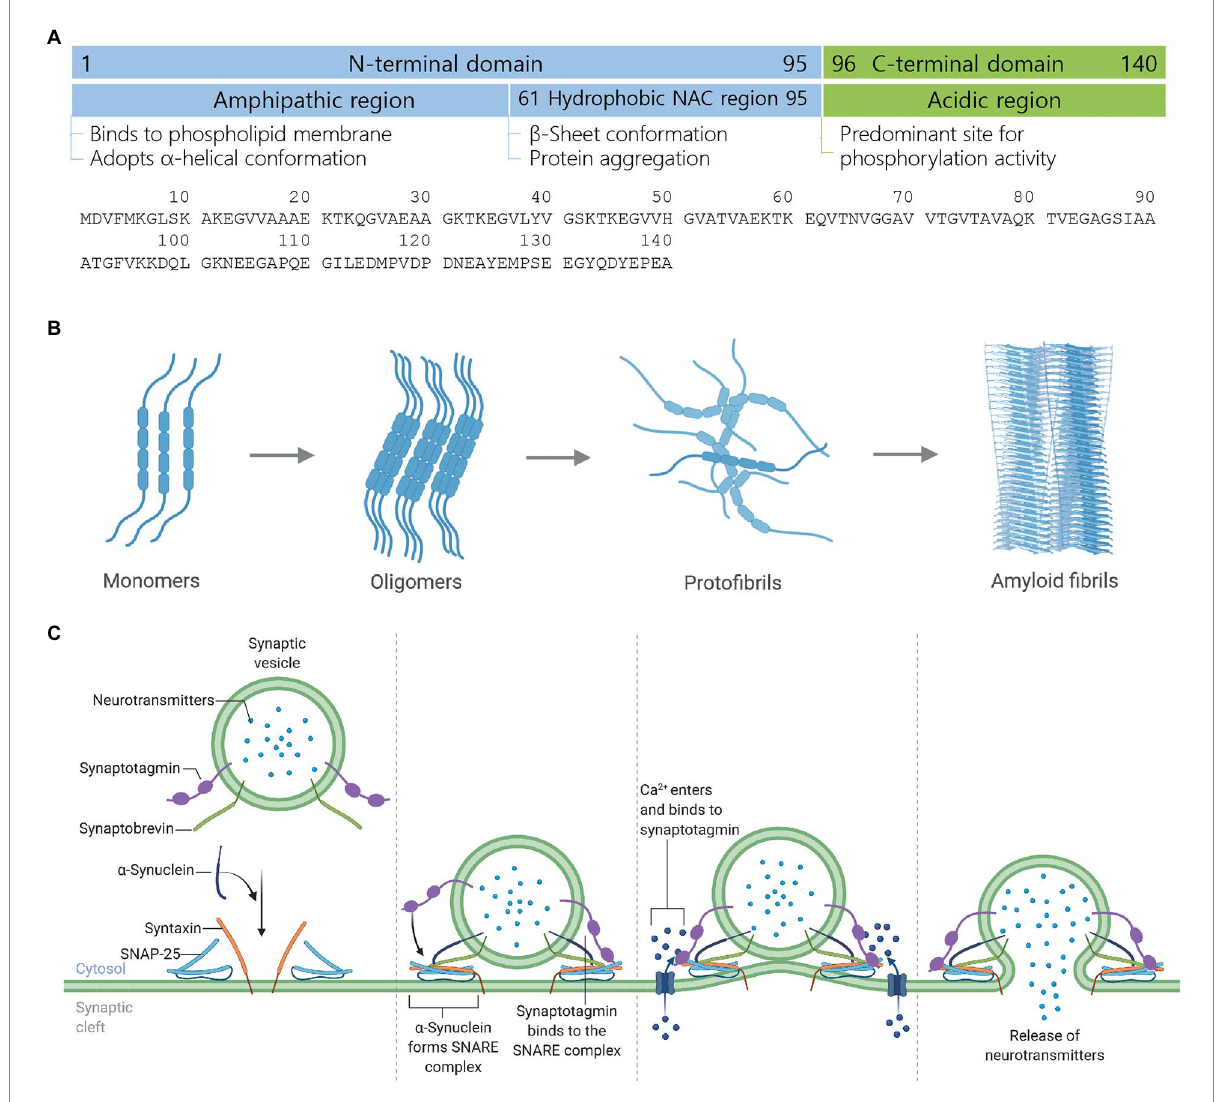
FIGURE 1 Structure, aggregate formation, and neurotransmission facilitation mechanism of α -synuclein. (A) Structure of α -synuclein highlighting different structural domains, their cardinal roles and an amino acid sequence. (B) Development of toxic α -synuclein aggregates. In the healthy brain, α - synuclein exists as a natively unfolded monomer. Upon mutation, multiplication, or unfavorable posttranslational modification, α -synuclein starts forming oligomers, which recruit further monomers and eventually form β -sheet-rich toxic amyloid fibrils. Amyloid fibrils form LB and LN, leading to neurodegeneration and cell death. (C) Mechanism of neurotransmission facilitation by α -synuclein. α -Synuclein is a presynaptic protein while synaptotagmin and synaptobrevin are synaptic vesicle membrane-associated proteins. During the docking of neurotransmitters-loaded synaptic vesicle onto the plasma membrane, α -synuclein binds to synaptobrevin while two other synaptic membrane proteins syntaxin and SNAP-25 are recruited to form the SNARE complex, which mediates vesicle priming. Action potential reaches the presynaptic terminal, calcium channel within the presynaptic plasma membrane opens, calcium ions enter into the cytosol, and bind to synaptotagmin, which leads to the exocytosis or release of neurotransmitters. Figure created with